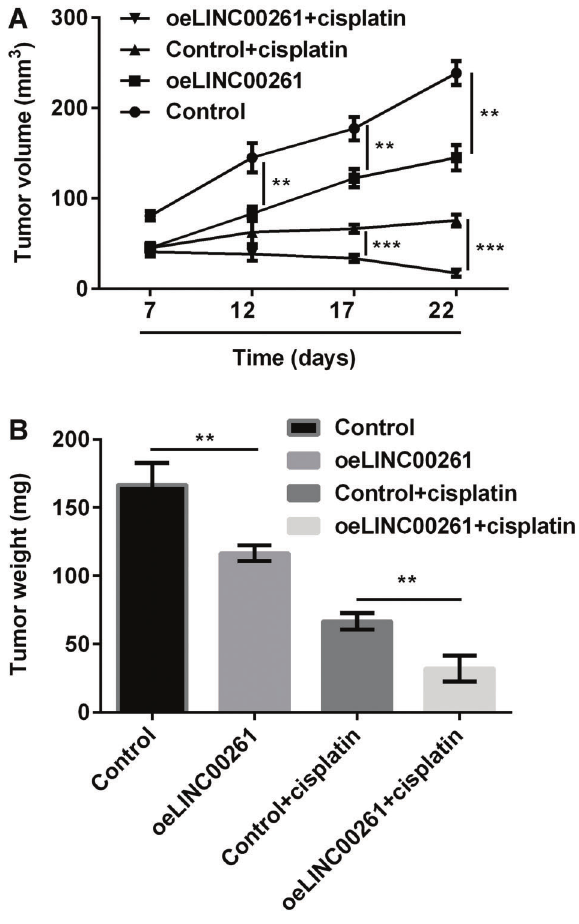
Figure 7. Effect of LINC00261 on tumor-inhibitory effect of cisplatin in vivo . A , oeLINC00261 decreased tumor volume after cisplatin treatment; B , oeLINC00261 decreased tumor weight after cisplatin treatment. Data are reported as means ± SD. **P o 0.01; ***P o 0.001